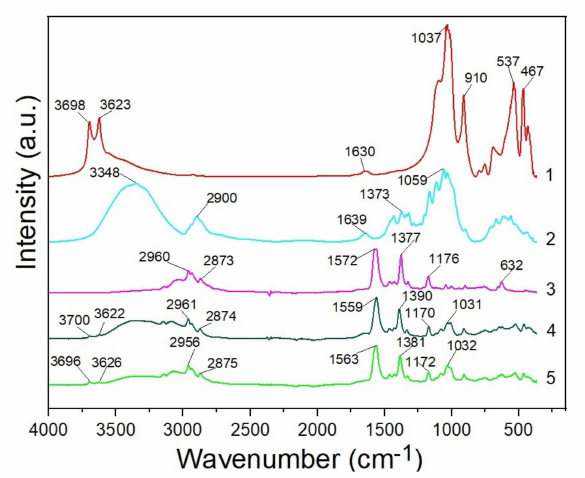
Figure 7. FTIR spectra of halloysite ( 1 ), MCC ( 2 ), BMImAc ( 3 ), IL/Hal (4) and IL/Hal/MCC-4 ionogel